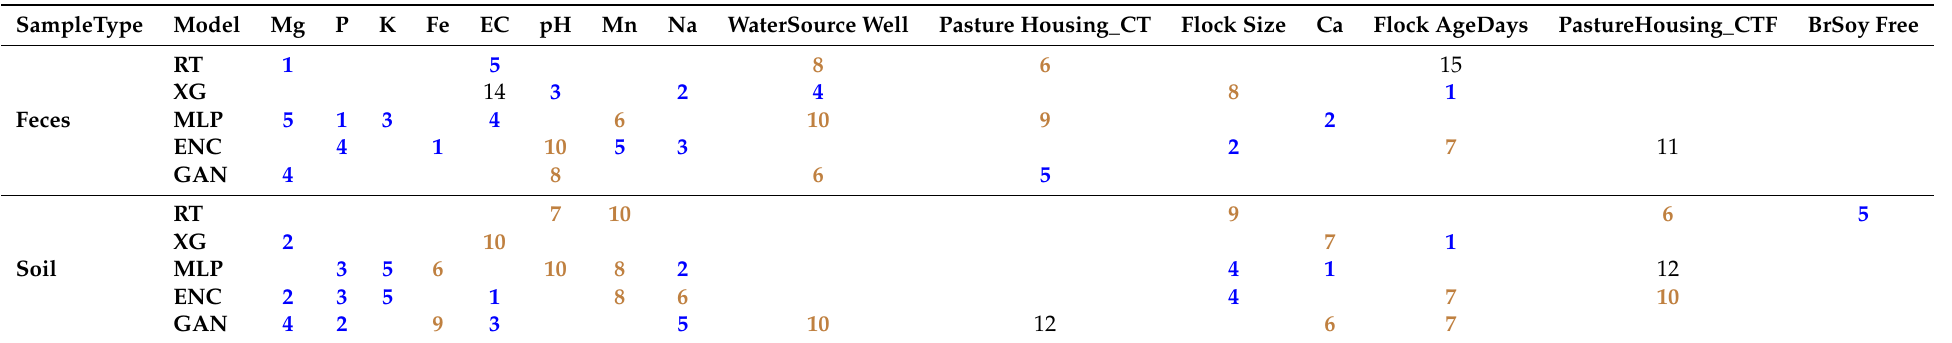
Table 3. The influential variables and their rank in respective algorithm for the prediction of Salmonella multidrug resistance (S_MDR). Please see Table A1 for variable descriptions. The top five ranks are shown in blue and the top ten in brown . Overall, the top five most influential variables for S_MDR in feces are Mg, Water_Source_Well, Pasture_Housing_CTF, pH, and EC, while the top five for soil are Mg, P, Na, EC, and Ca.